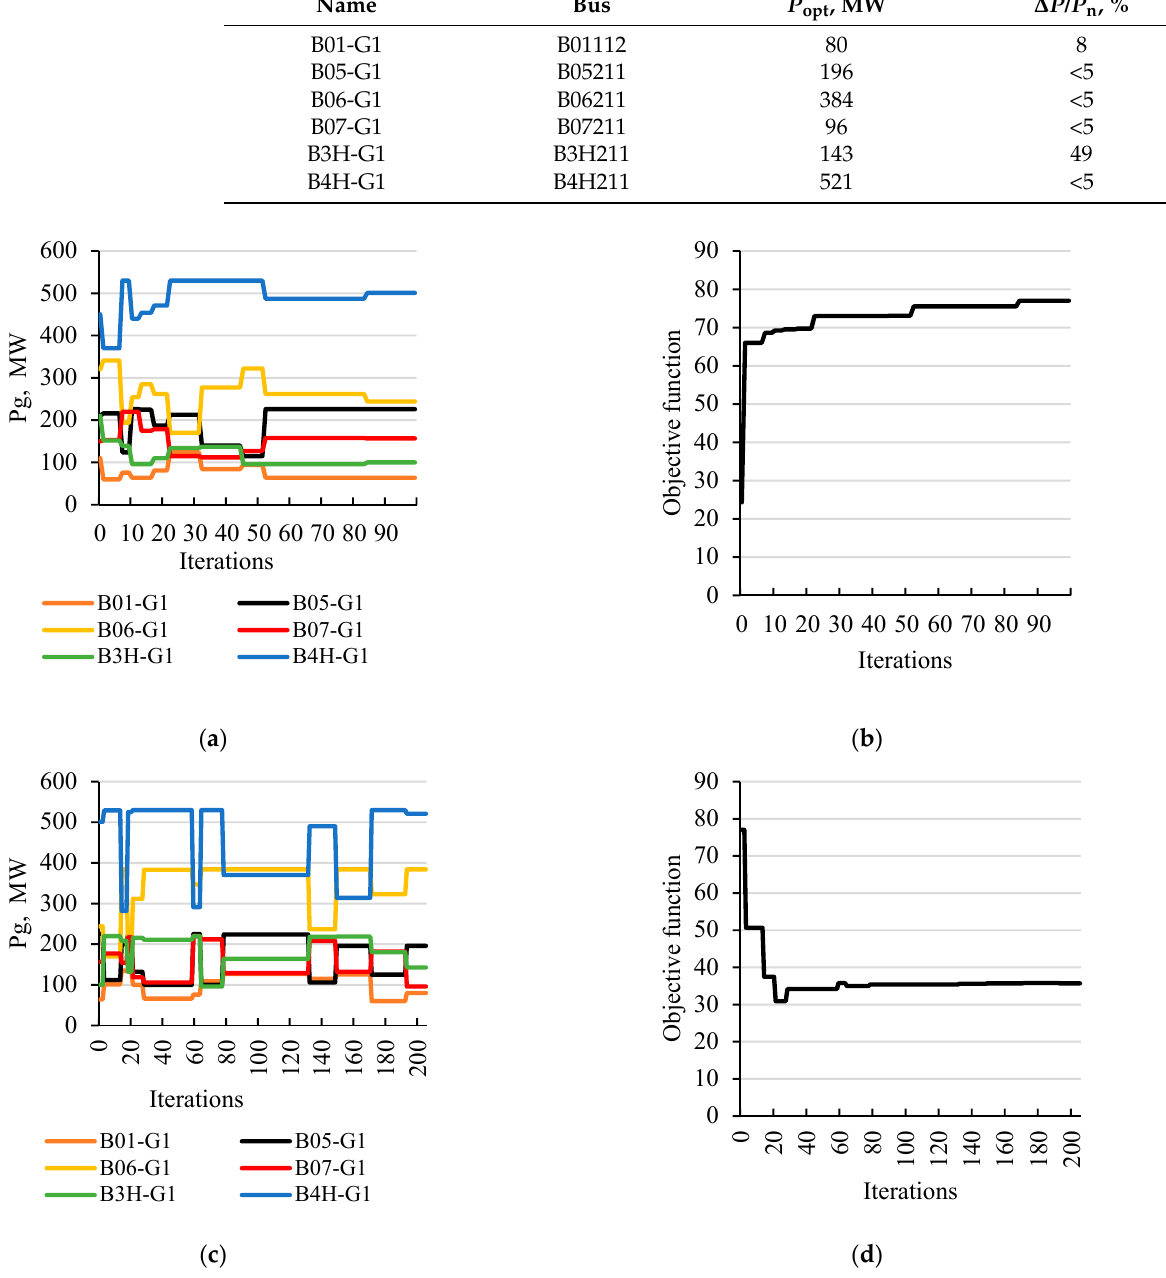
Figure 7. The process of determining the maximum SPA for case 2; ( a ) changing the generation distribution to determine the maximum (global) SPA; ( b ) a graph of changes in the value of the objective function (maximum SPA); ( c ) changing the generation distribution to determine a maximum safe SPA; ( d ) graph of changes in the value of the objective function with the penalty function (maximum safe SPA).